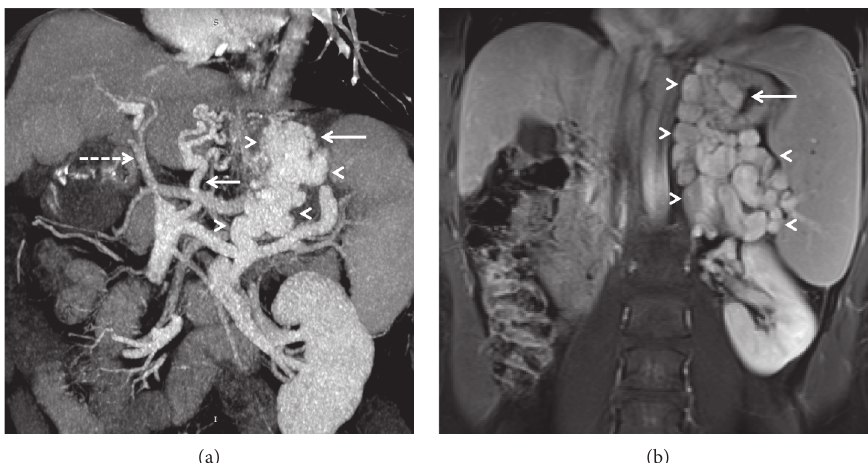
Figure 2: Coronal-oblique MIP (a) and coronal MRI (b) images from two different patients depicting gastrorenal shunts (arrowheads) with varices protruding into the gastric lumen (long solid arrows). Note. The attenuated main portal vein (dashed arrow) and prominent left gastric vein (short solid arrow) in